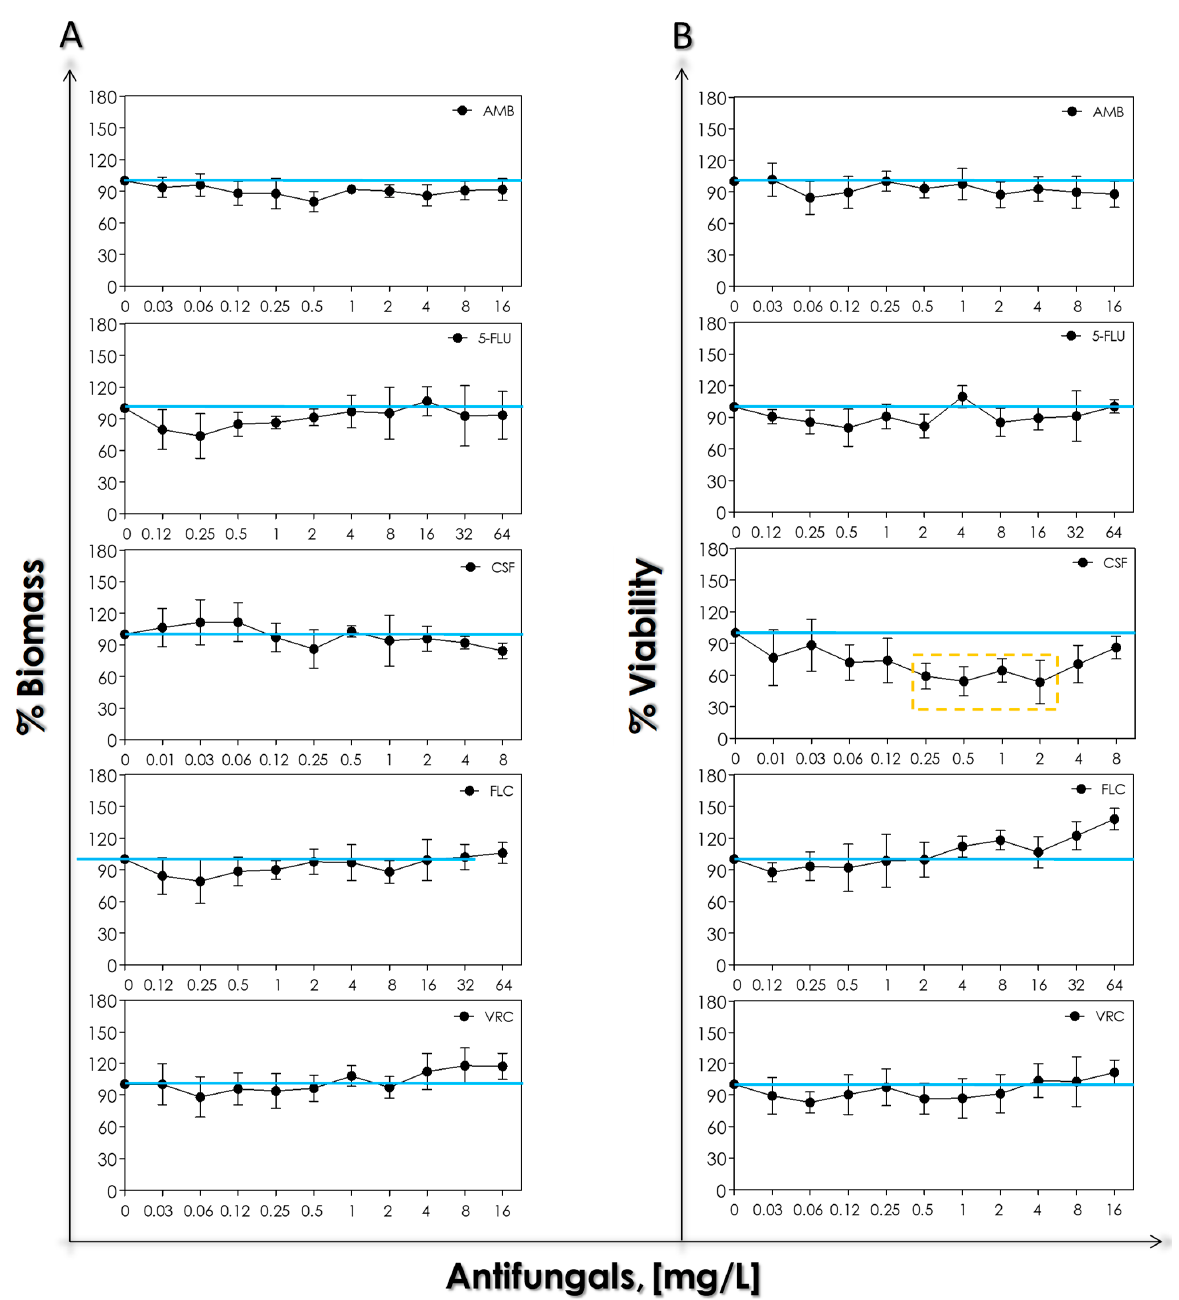
Figure 5. Biomass ( A ) and viability ( B ) of biofilm formed by S. cerevisiae HUPE-Sc1 strain over a polystyrene surface exposed to different concentrations of antifungals: amphotericin B (AMB), 5- flucytosine (5-FLU), caspofungin (CSF), fluconazole (FLC) and voriconazole (VRC). The results were assessed spectroscopically (biomass at 590 nm and viability at 492 nm) and expressed as the mean of metabolic and biomass percentages compared to untreated biofilms (control), which correspond to 100% (blue line). The graphs exhibit the mean ± standard deviation of three independent experiments. The dashed box represents the concentrations of CSF that caused statistically significant re- duction in cell viability in relation to the respective control ( p < 0.05; one-way ANOVA analysis of variance and Dunnett’s multiple comparison test).